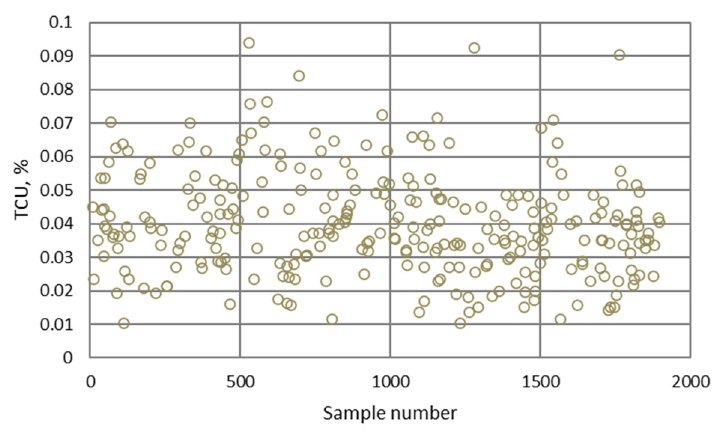
Figure A40. NN3 model—testing dataset.